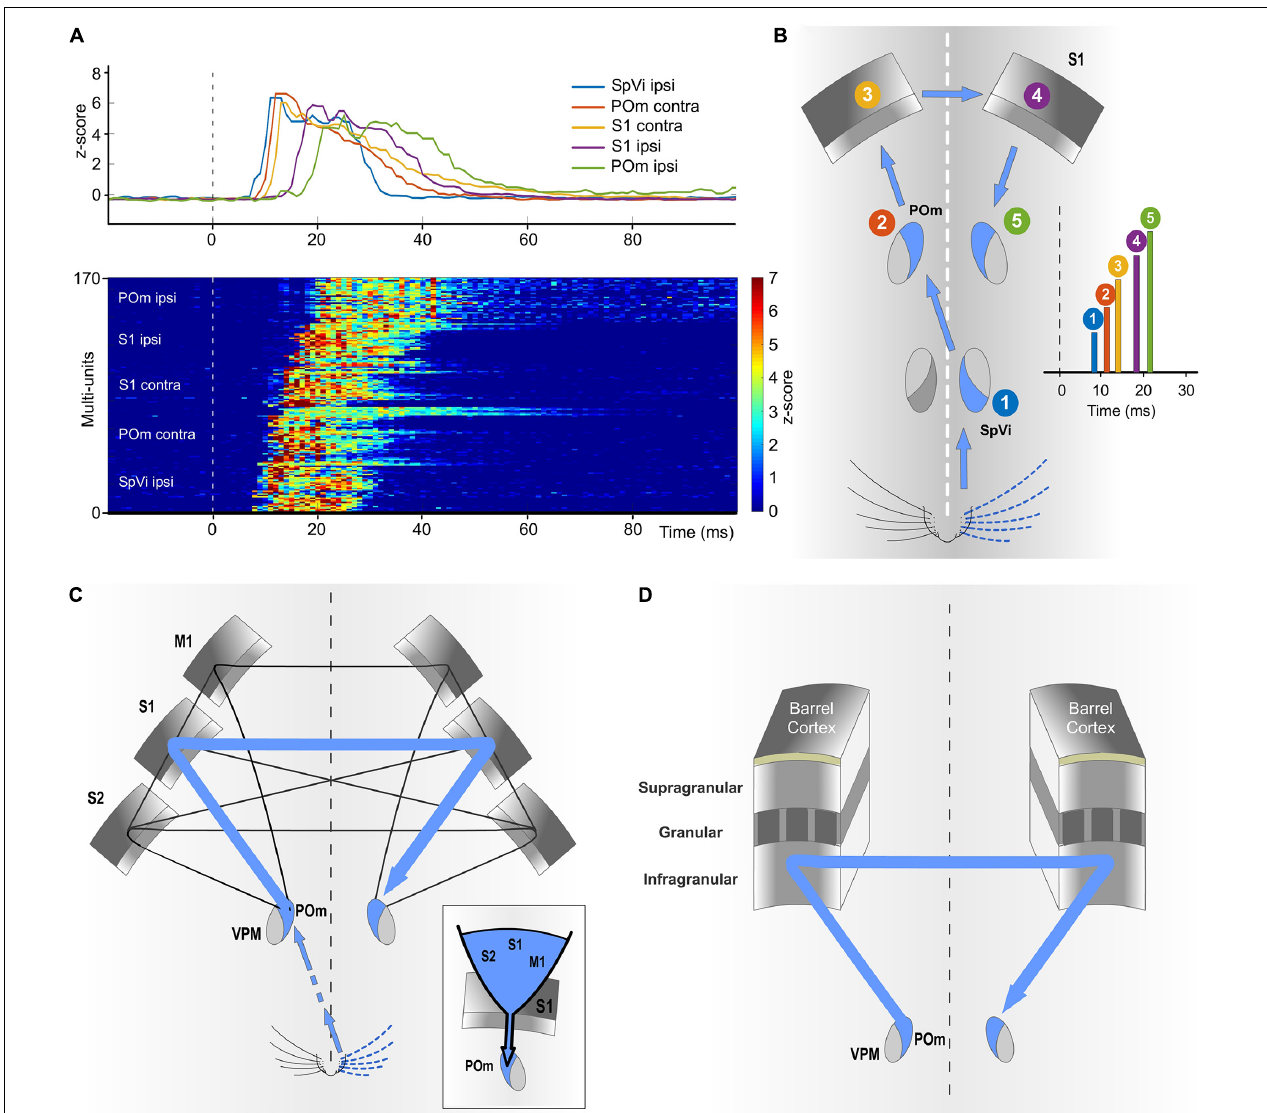
FIGURE 14 | The POm-POm loop is formed by a functional network of parallel thalamocortical, interhemispheric, and corticothalamic projections. (A) Demonstrative responses to whisker stimulation in z -score across multi-units sequentially displayed along the POm-POm loop. The average responses are shown above. (B) Illustration recapitulating the mean onset latencies across the different brain structures implicated in the POm-POm loop. (C) Although different cortical areas are implicated, our results revealed that S1 plays a central role in this functional loop. The inset illustrates the idea that S1 may act as a funnel collecting activity from different areas and sending this information via corticothalamic projections to POm of the same hemisphere. This complex interhemispheric loop allows bilateral integration in the thalamus and is implicated in the bidirectional transmission of sustained activity between the higher-order thalamus and the cortex. (D) Our results indicate that the transmission of sustained activity across the POm-POm loop is supported by the infragranular layer. This loop could be also present in other sensory modalities.